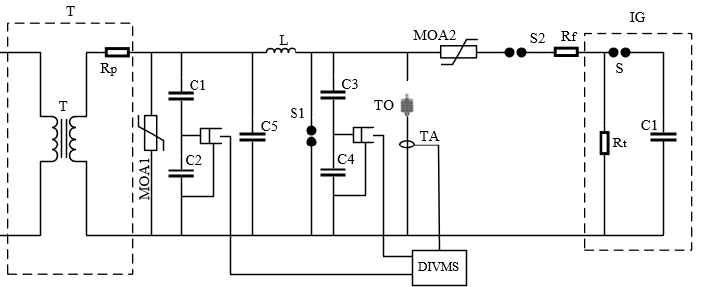
Figure 10. Combined test circuit diagram of high impulse current and power frequency